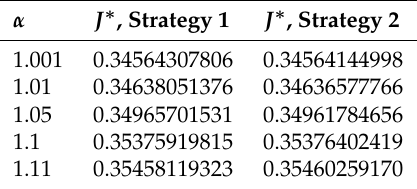
Table 2. J ∗ for α > 1, Example